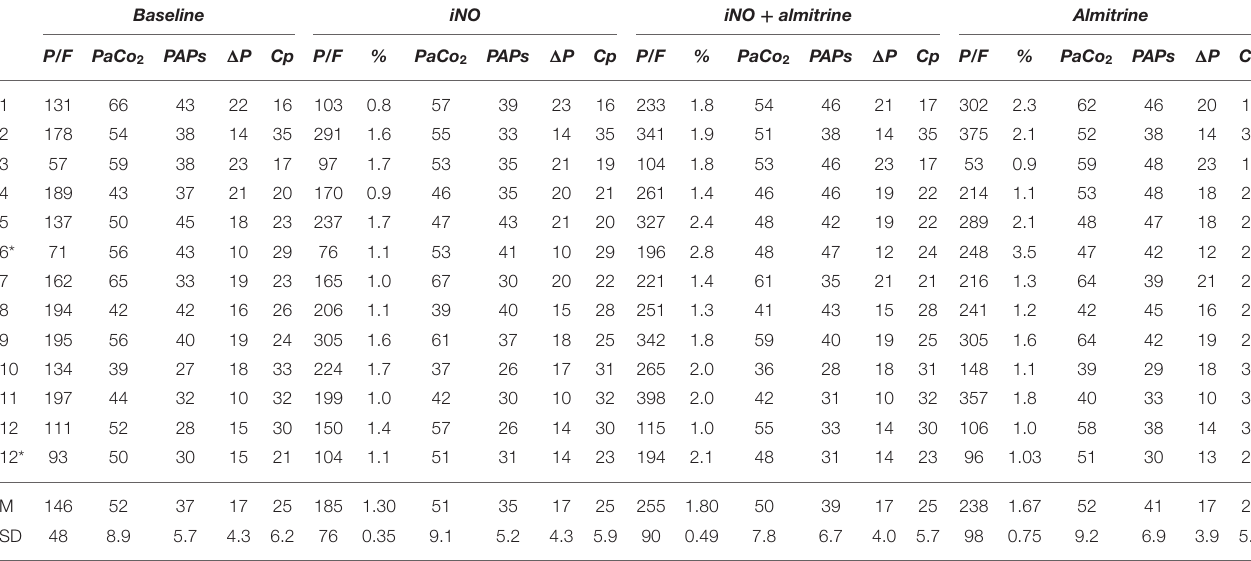
TABLE 2 | Ventilatory Pattern During the Protocol.